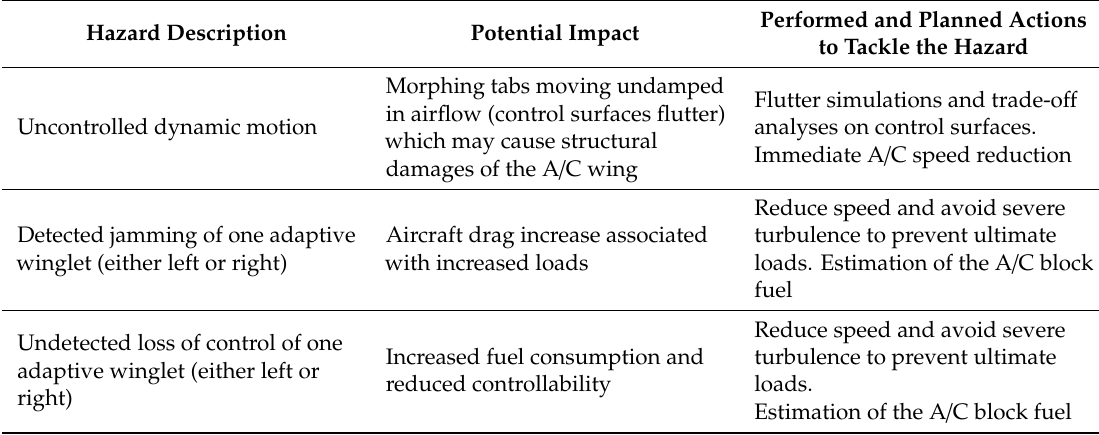
Table 2. Potential failures identified in morphing winglet preliminary fault and hazard assessment (FHA).